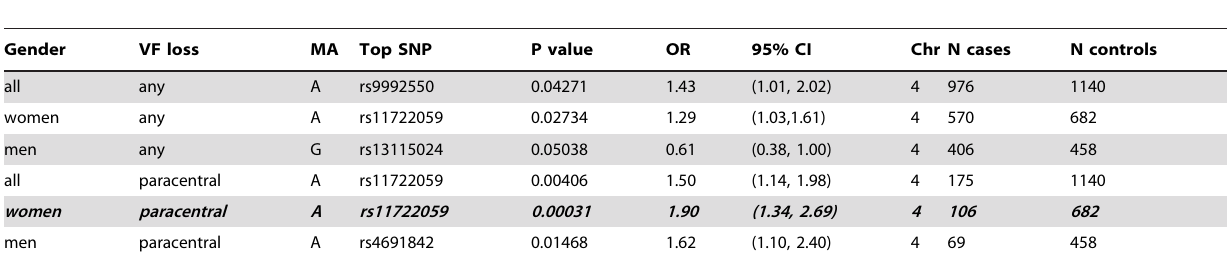
Table 1. Association between GUCY1A3/GUCY1B3 single nucleotide polymorphisms (SNPs) and POAG in the Glaucoma Gene and Environment (GLAUGEN)